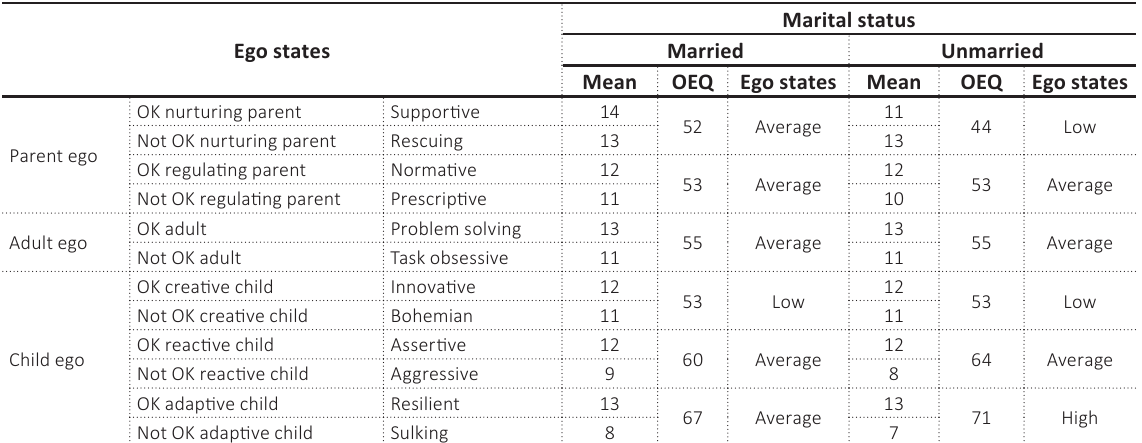
Table 3. Level of ego states based on marital